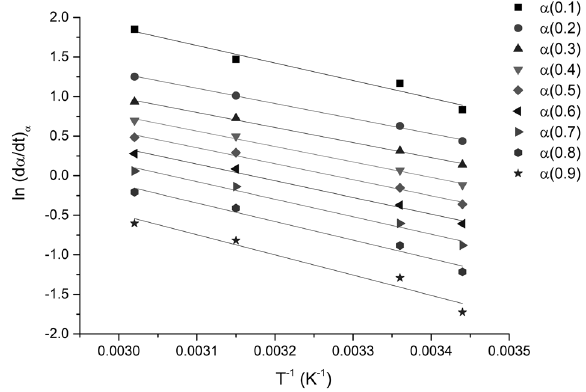
vs. the degree of caffeine a